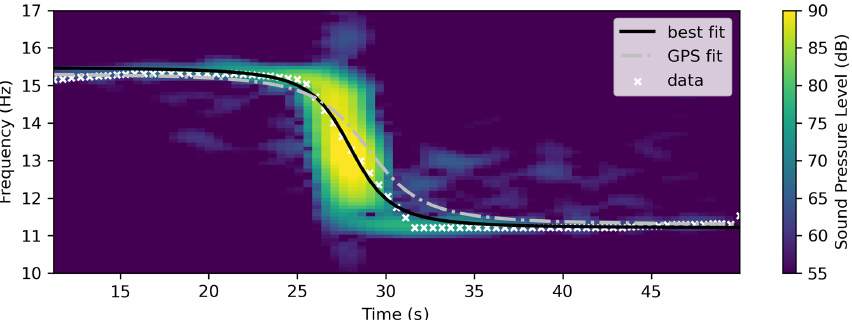
Figure C1. Doppler shift of helicopter-sourced infrasound from a Bell 206 helicopter flying above Squint Arch. Decibel amplitudes are relative to 20 × 10 − 6 PaHz − 1 .